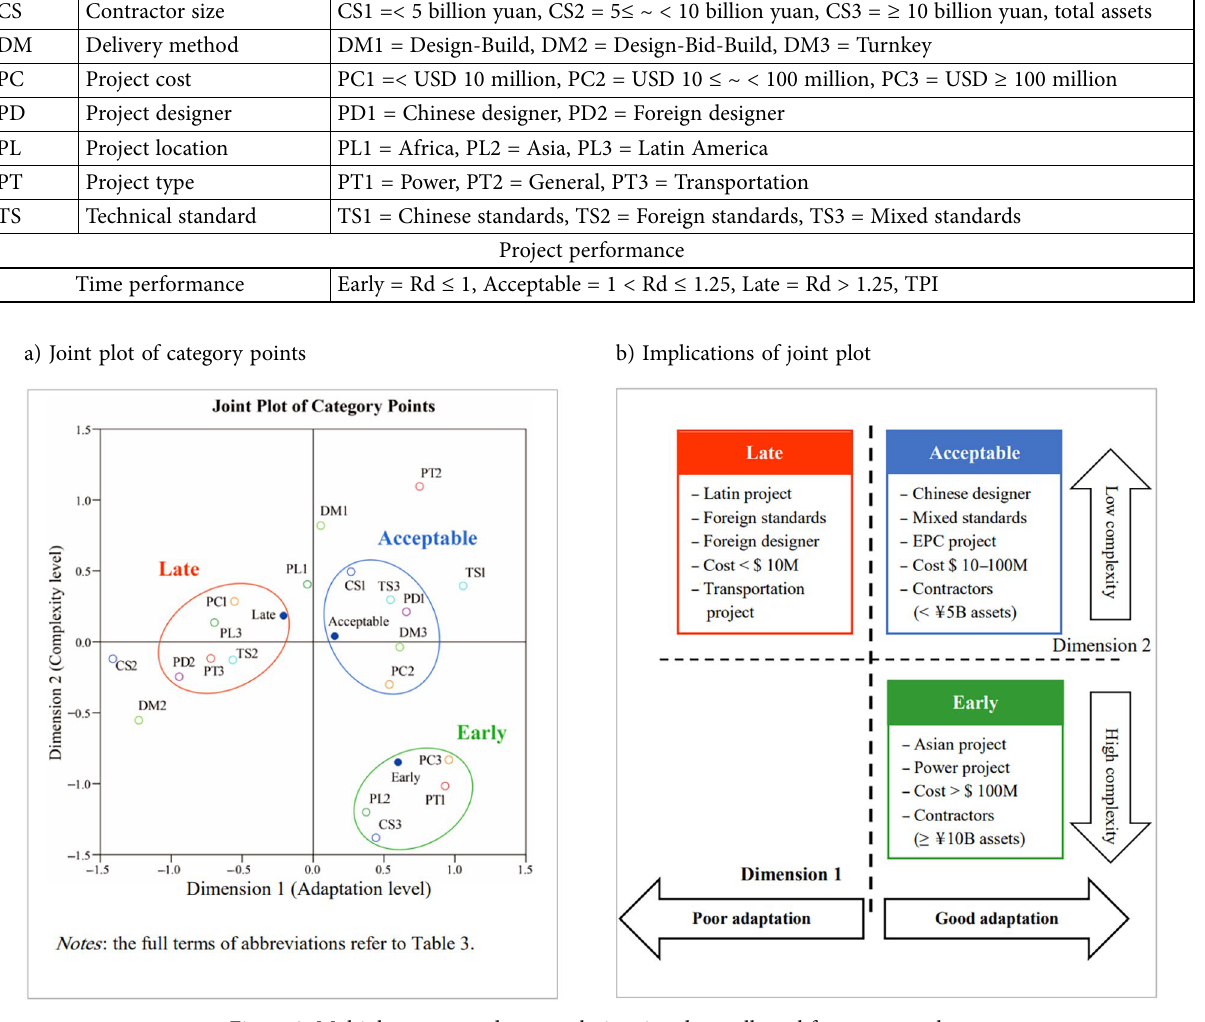
Figure 3. Multiple correspondence analysis using data collected from